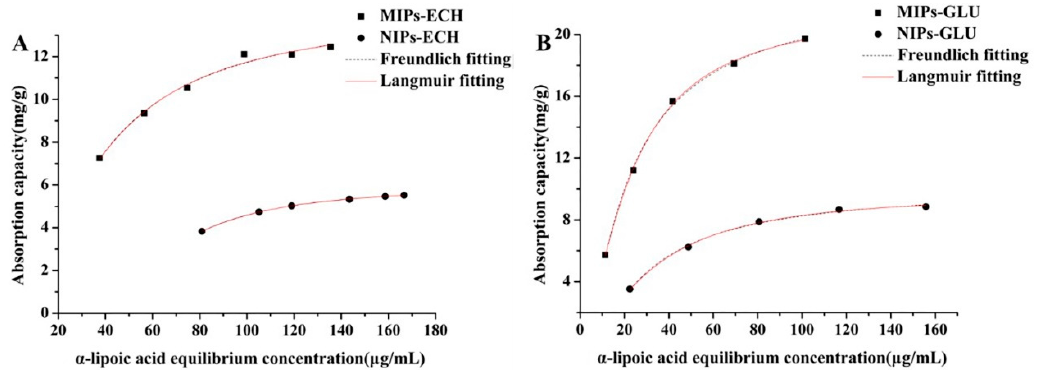
Figure 5. Adsorption isotherms of the ( A ) MIPs–ECH and NIPs–ECH, ( B ) MIPs–GLU and NIPs–GLU for ALA at 30 °C. for ALA at 30 ◦